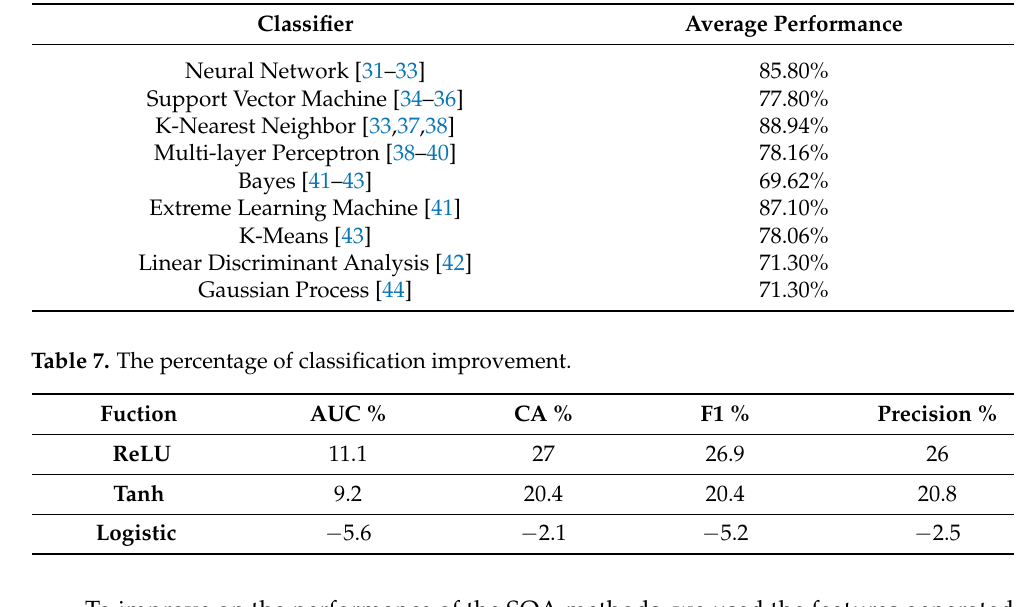
Table 6. Performance comparisons between SOA techniques reported in [30]. Similar EEG-based works have reported an overall recognition rate of 82.9%.